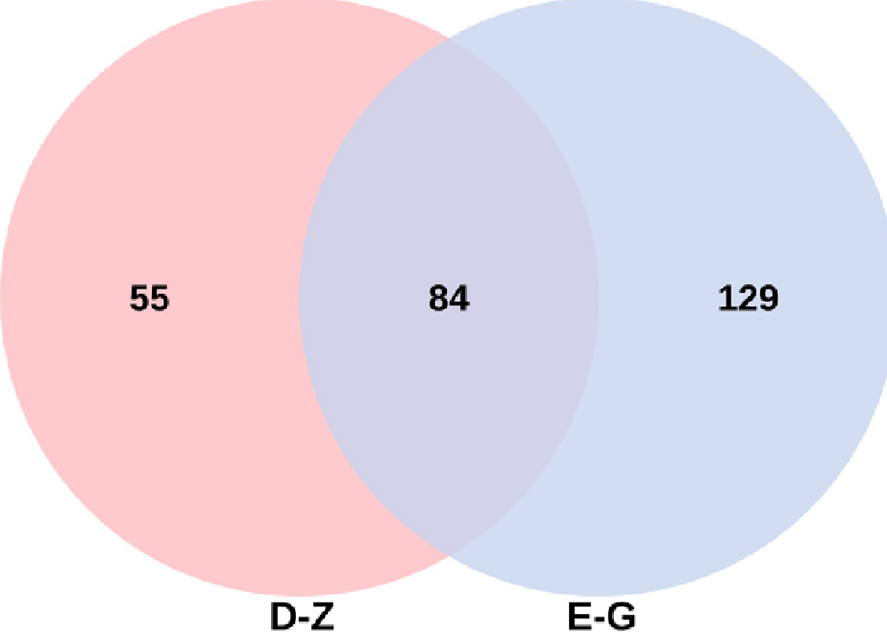
Fig 1. Venn diagrams of OTUs from medium-temperature Daqu and high-temperature Daqu.